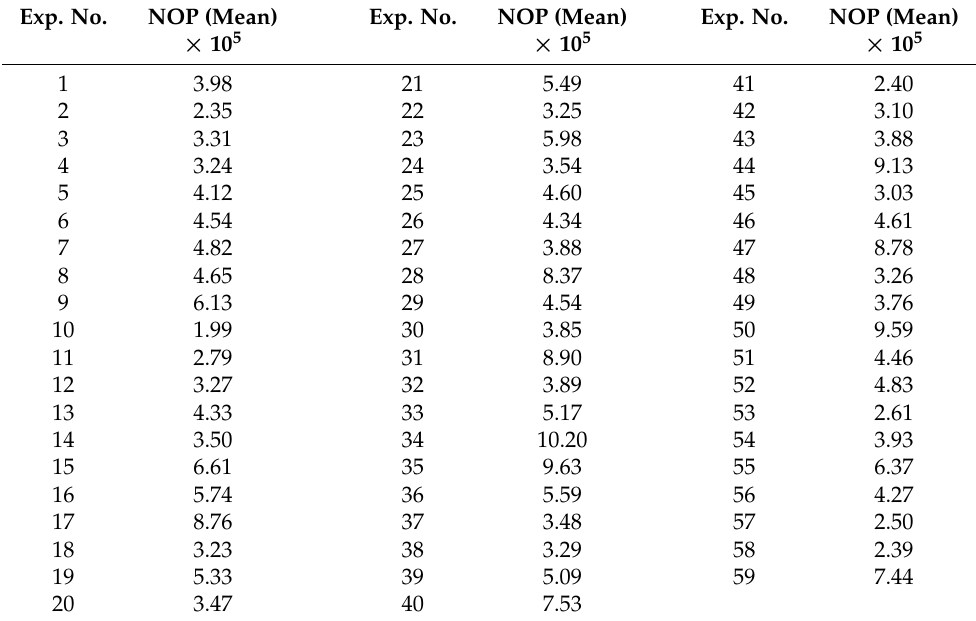
Table 4. Number of pixels (NOP) for the conducted experiments. Exp. No. Exp. No.